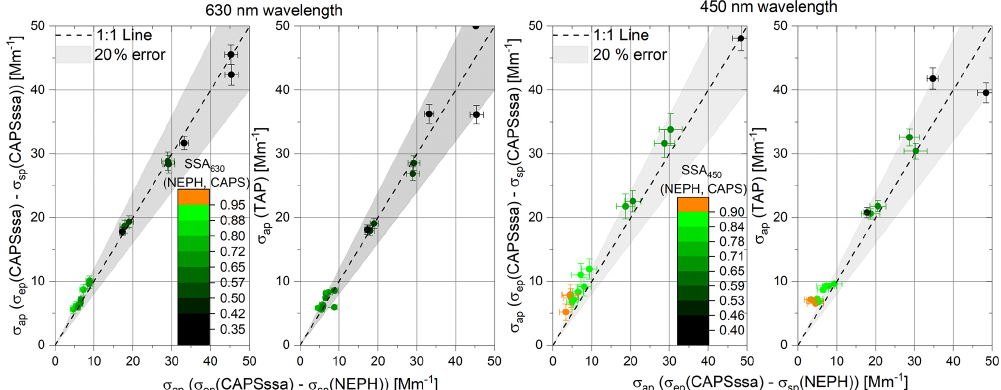
Figure 5. Scatter plots of measured 450 and 630nm wavelength absorption coefficients of external mixtures of AQ and AS for different instrument combinations. The colour code represents the SSA value of the respective data point. An error band of ± 20% was applied to the 1 : 1 line, which is required by Laj (2020) for light-absorption measurements. Error bars shown represent propagated instrument precisions (1 σ ). Table 4. Linear regression results of scattering ( σ sp ), extinction ( σ ep ) and absorption ( σ ap ) coefficients from Figs. 3–5 for external mixtures of AQ and AS particles, given as slopes ( m ), Pearson R and y axis intercepts ( b ). σ sp (CAPS) σ sp (CAPS, TAP) σ ep (NEPH, TAP) σ ap (TAP) vs. vs. vs. vs. σ sp (NEPH) σ sp (NEPH) σ ep (CAPS) σ ap (CAPS, NEPH) 630nm m 1.07 ± 0.03 1.08 ± 0.05 0.99 ± 0.03 0.92 ± 0.07 R 0.99 0.97 0.99 0.95 b [Mm − 1 ] − 1 . 84 ± 0.57 − 2 . 15 ± 1.12 0.91 ± 0.93 0.78 ± 0.68 450nm m 0.99 ± 0.05 1.06 ± 0.03 0.98 ± 0.03 1.04 ± 0.08 R 0.97 0.99 0.99 0.96 b [Mm − 1 ] 1.14 ± 2.27 − 4 . 60 ± 1.51 3.37 ± 1.71 2.13 ±